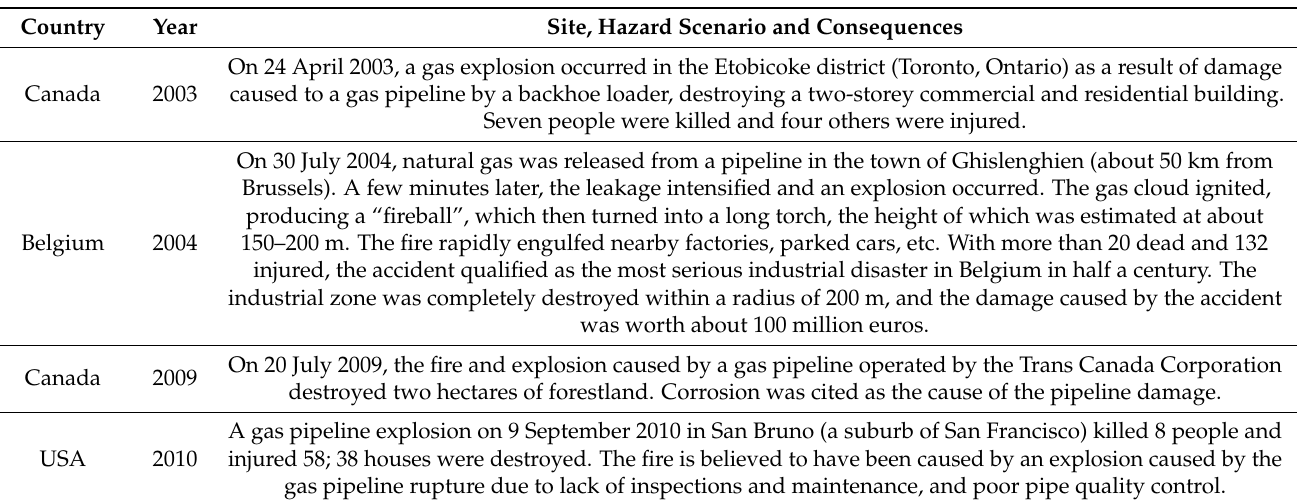
Table 2. Natural gas pipeline accidents [5,10].